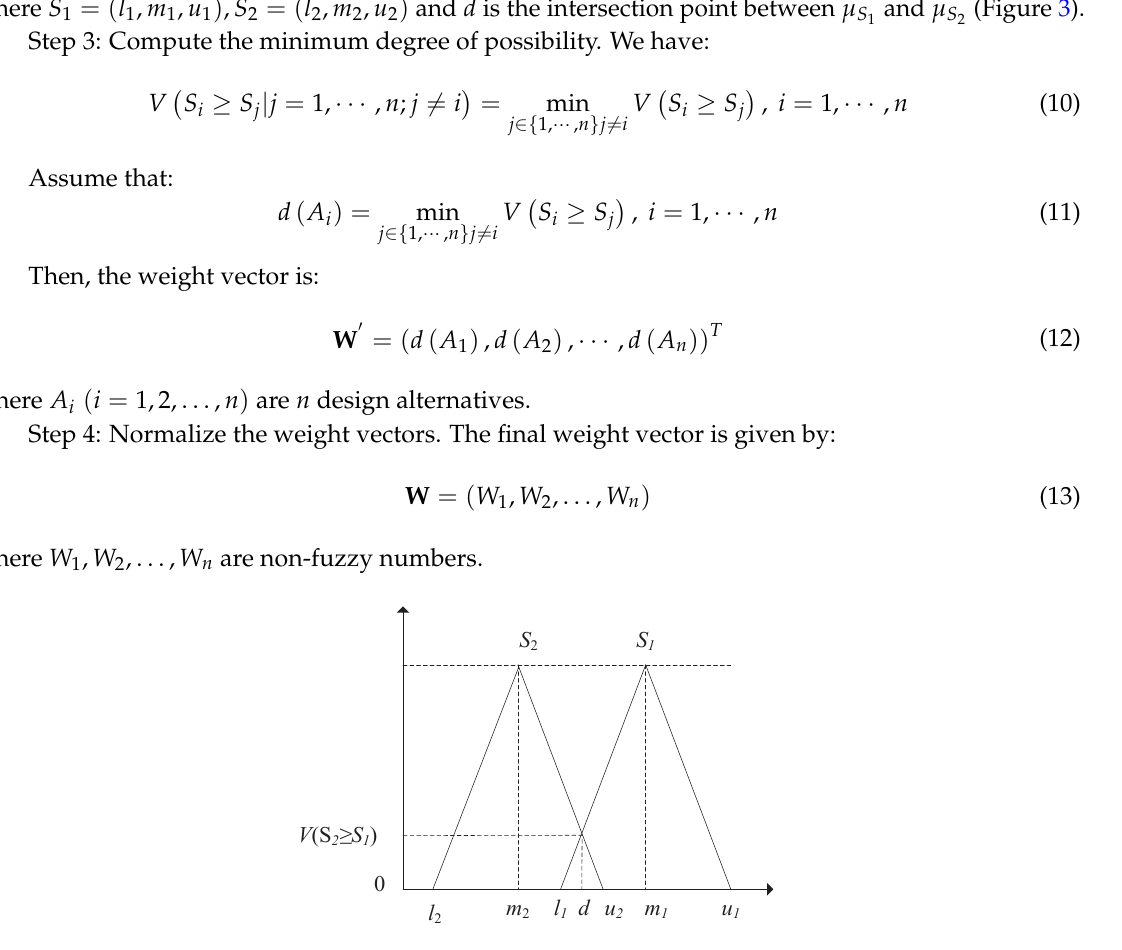
Figure 3. The degree of possibility V ( S 2 ≥ S 1 )